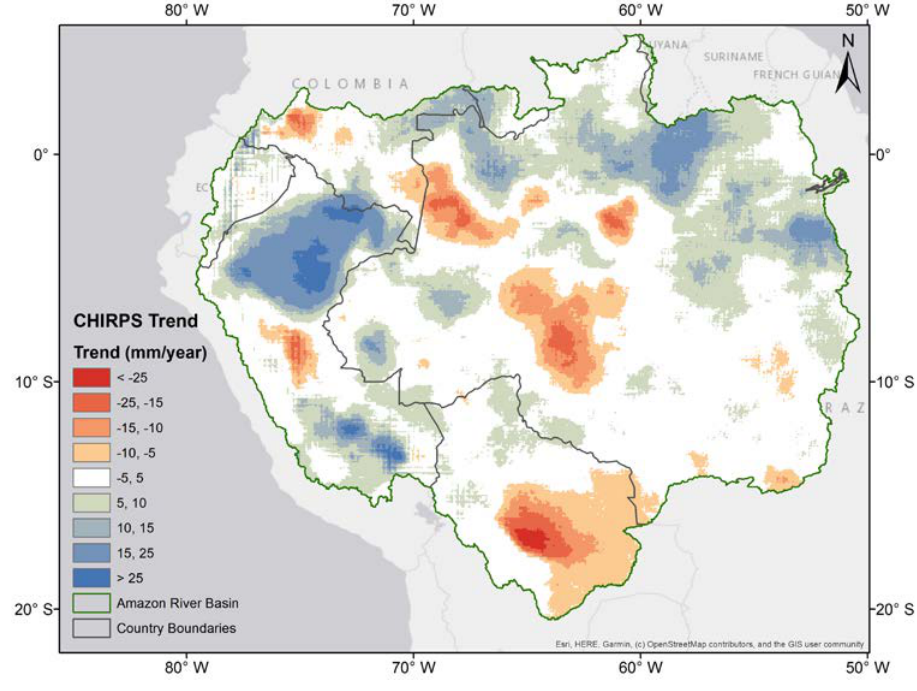
Figure 4. CHIRPS trends from 1981 to 2017.